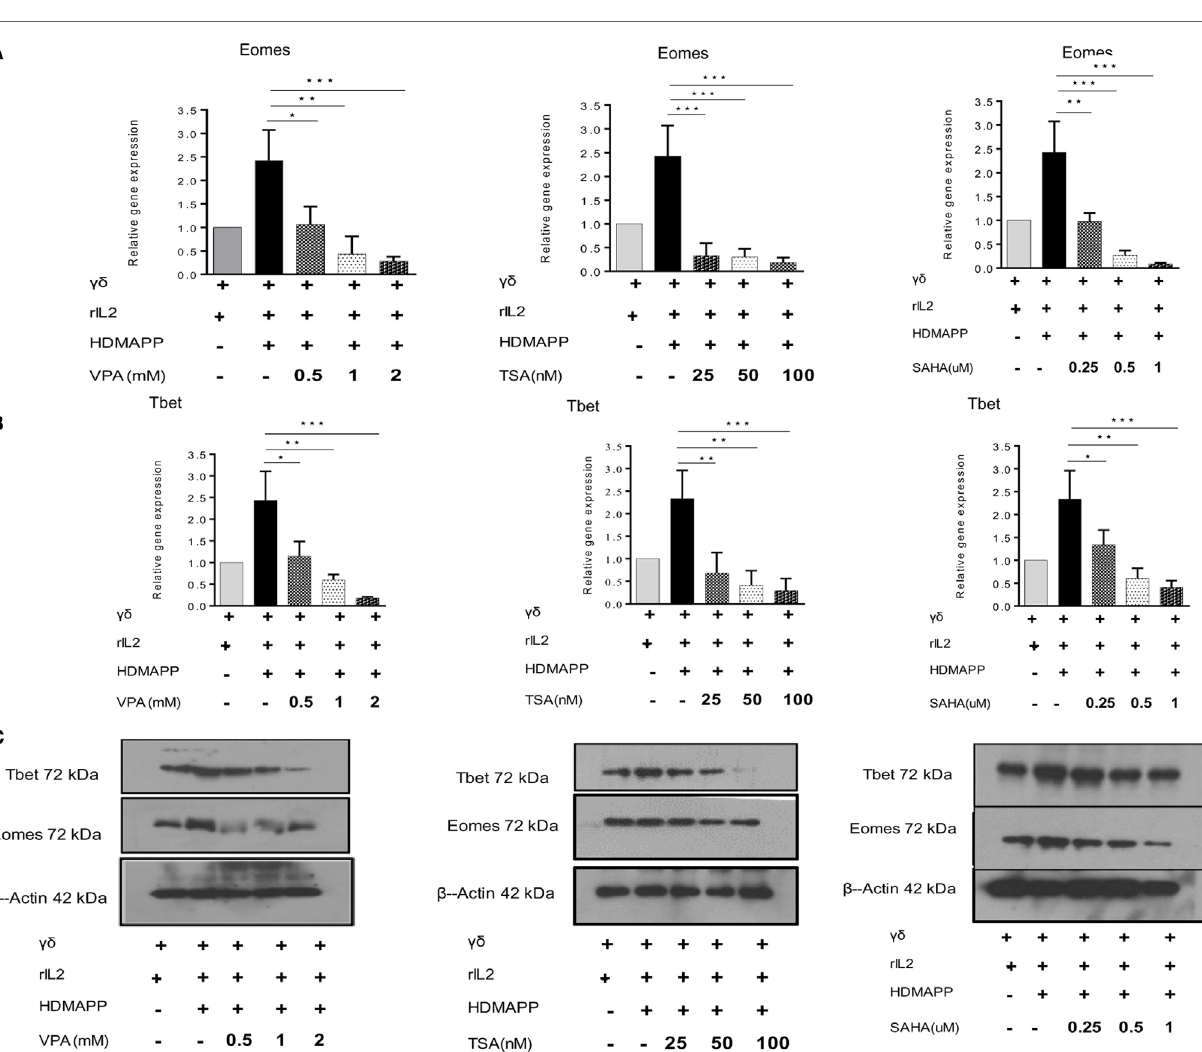
FigUre 4 | Histone deacetylases (HDAC) inhibition abrogates expression of transcription factors regulating effector functions of γδ T cells. The m-RNA expression of Eomes (a) and T bet (B) in γδ T cells activated with HDMAPP, in the presence or absence of HDAC inhibitors sodium valproate, Trichostatin-A, and suberoylanilidehydroxamic acid at different concentrations was quantified by quantitative real-time PCR. The results indicated are cumulative mean of relative gene expression normalized to 18S r-RNA where * p < 0.05, ** p < 0.005, *** p < 0.0005, compared with γδ T cells activated with HDMAPP. The data shown are representative of three independent experiments. (c) The protein level expression of T bet and Eomes was detected by western blotting. HDAC inhibitor treatment decreases the expression of T-bet and Eomes. β -actin was maintained as loading control. The blots shown are representative of three